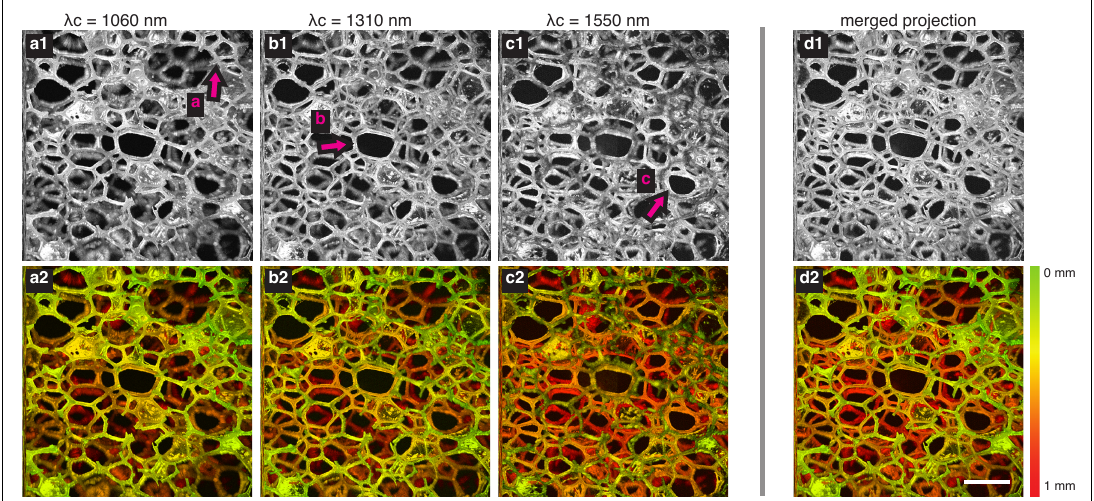
Figure 2. Projection images of polyurethane sponge. ( a – c ) MIP of the imaged volume from the individual interferometers where the source spectrum is centered at 1060 nm, 1310 nm, and 1550 nm, respectively. The arrows (a–c) highlight the in-focus depth in the imaging field. ( d ) MIP of the merged volume. The first row shows MIPs in grayscale, and the second row shows colorized MIPs with pseudo-colormap encoding the depth. Scale bar = 1